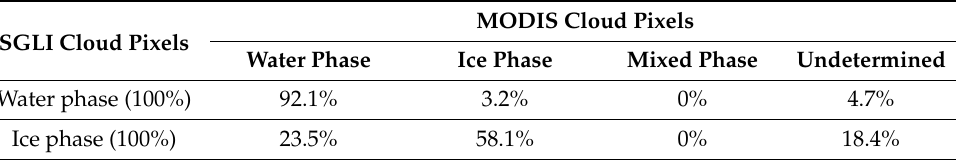
Table 2. Percentage distributions of MODIS-detected cloud phases for total counts of SGLI-detected water and ice cloud